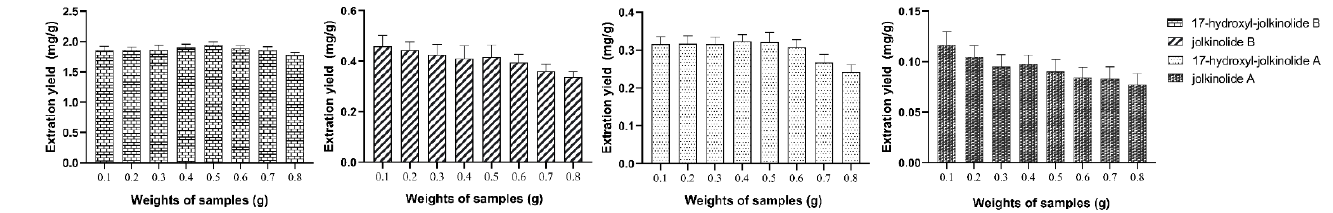
Figure 7. The effect of weights of samples.